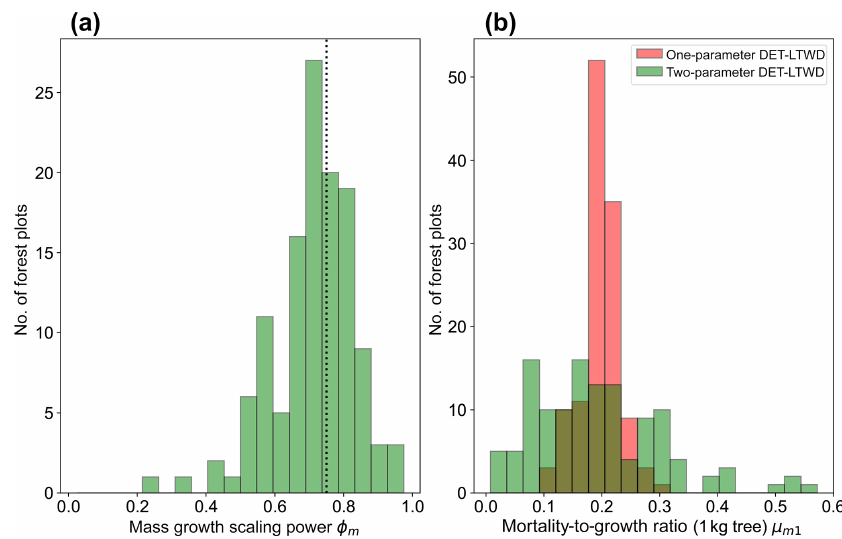
Figure 8. (a) Results for the growth scaling power φ m when fitting the two-parameter DET-LTWD via MLE for mass data from all 124 individual forest plots. The vertical black line shows the value φ m = 0 . 75 predicted by MST allometry. (b) Results for the fitted mortality- to-growth ratio µ m1 for both the one- and two-parameter DET-LTWD via MLE for mass data from all 124 individual forest plots.